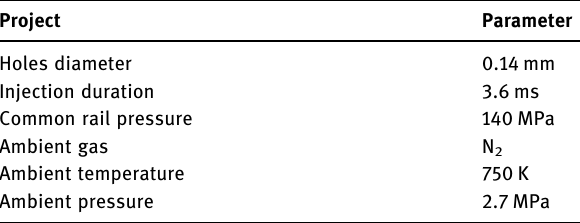
Table 5: Conditions of spray